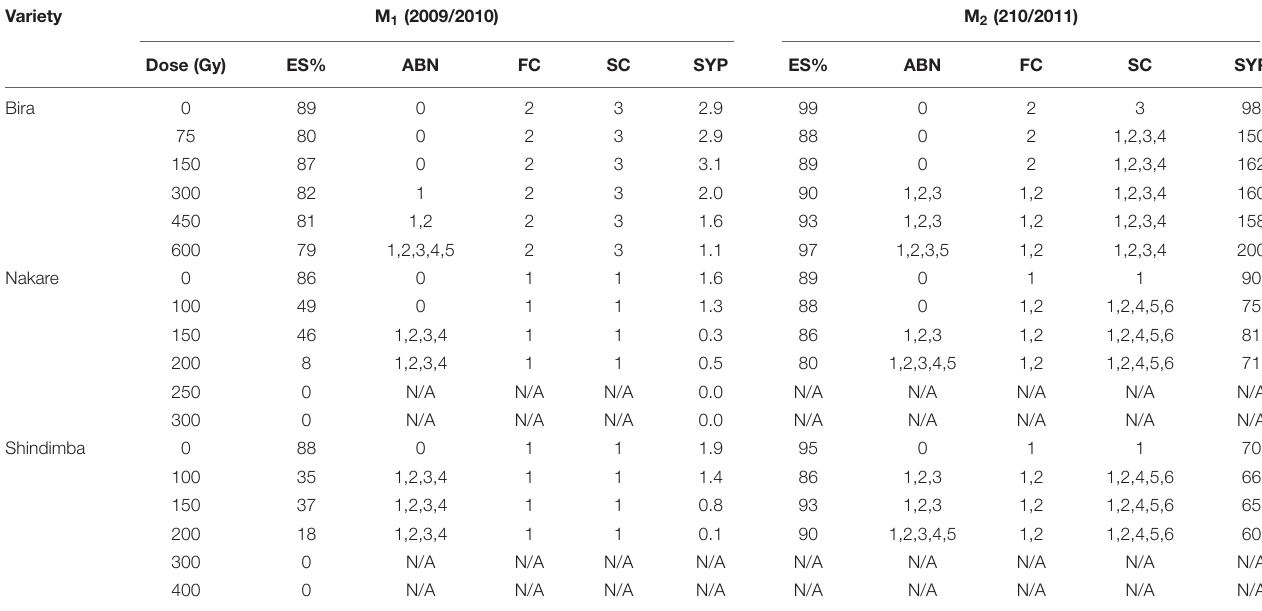
TABLE 2 | Phenotypic characteristics of mutants observed during the first two seasons 2009/2010 and 2010/2011 at Mannheim Research Station.